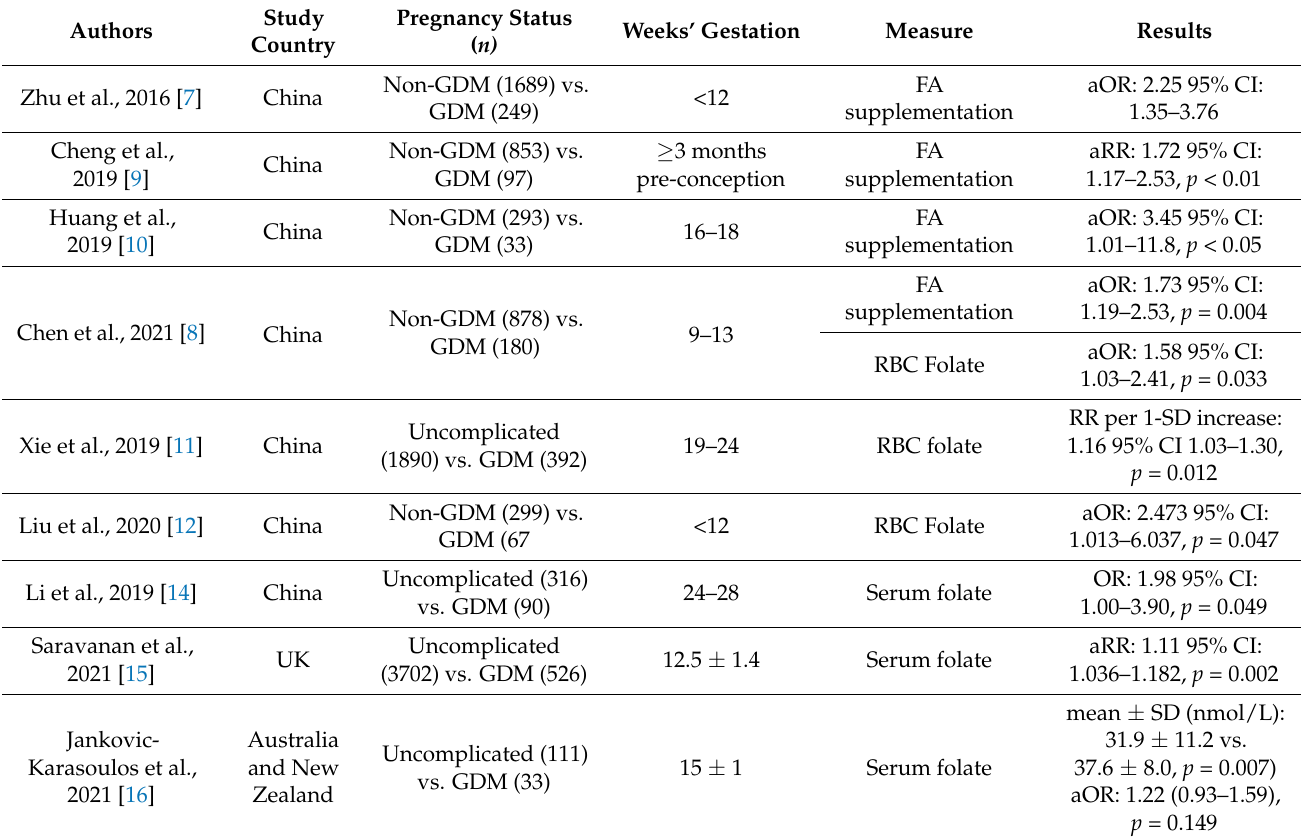
Table 1. Summary of research on the relationship between folate and